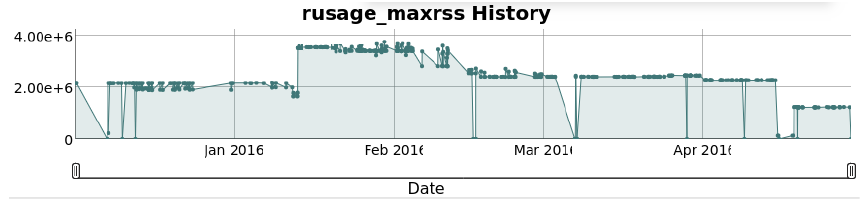
Figure 3. CI regression test memory